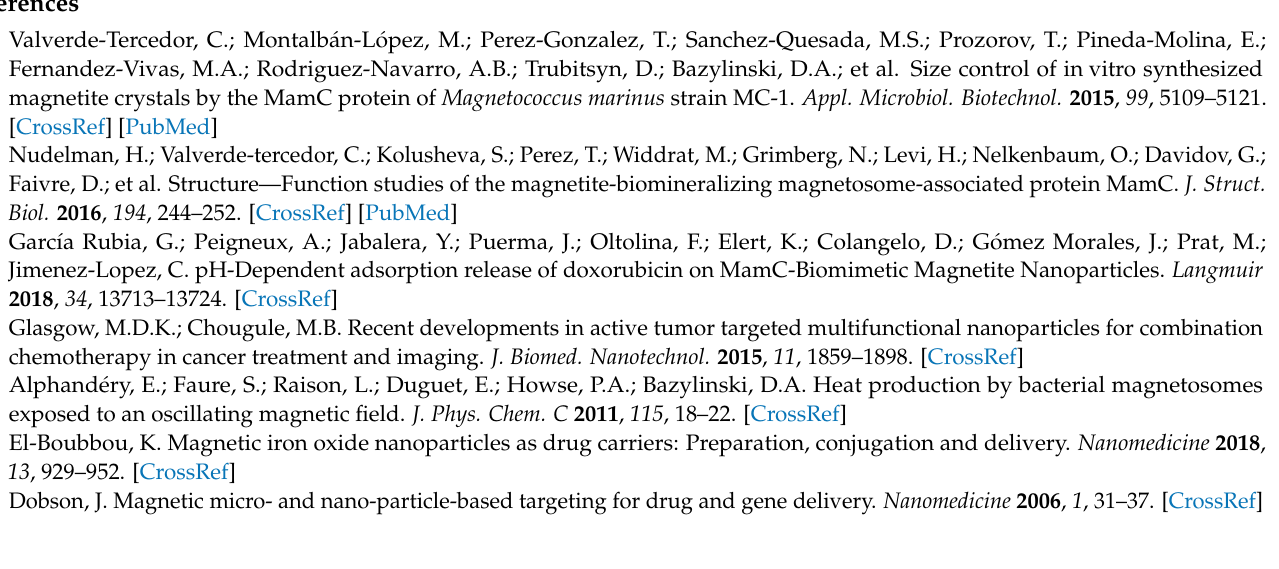
DOXO; Figure S3. Time evolution of the temperature increase caused by PLGA(BMNPs) nanoassem- blies following exposure to AMF of different magnetic field strengths at a fixed frequency of 120 kHz; Figure S4. Time evolution of the temperature of PLGA(BMNPs) suspension at different laser power densities; Table S1. Summary of SAR and ILP calculations concerning TAT–PLGA(DOXO-BMNPs) at different intensities and at a fixed frequency of 120 kHz, after 30 s of exposure. Sample volume, 0.2 mL; particle concentration, 10 mg/mL; Table S2. Summary of SAR and ILP calculations concern- ing PLGA(BMNPs) at different intensities and at a fixed frequency of 120 kHz, after 30 s of exposure. Sample volume, 0.2 mL; particle concentration, 10 mg/mL; Table S3. Summary of SAR calculations at different laser power densities (0.5, 1, and 2 W/cm 2 ), after 120 s of exposure. Sample volume, 0.2 mL; particle concentration, 19